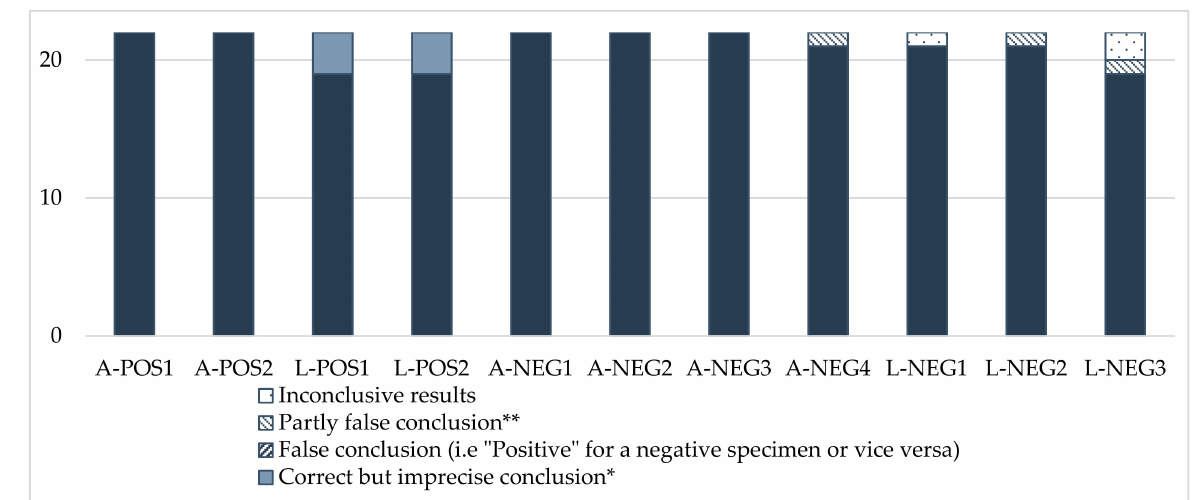
Figure 1. Analytical conclusions. * For larvae: “Positive identification of the Small Hive Beetle, A. tumida ”, instead of “Suspected identification of the Small Hive Beetle, A. tumida . Further analysis is required to ascertain the identification”, as precisely expected in this case, where identification was based on morphology only. ** “Suspected, further analysis required in confirmation”, whereas the specimen was